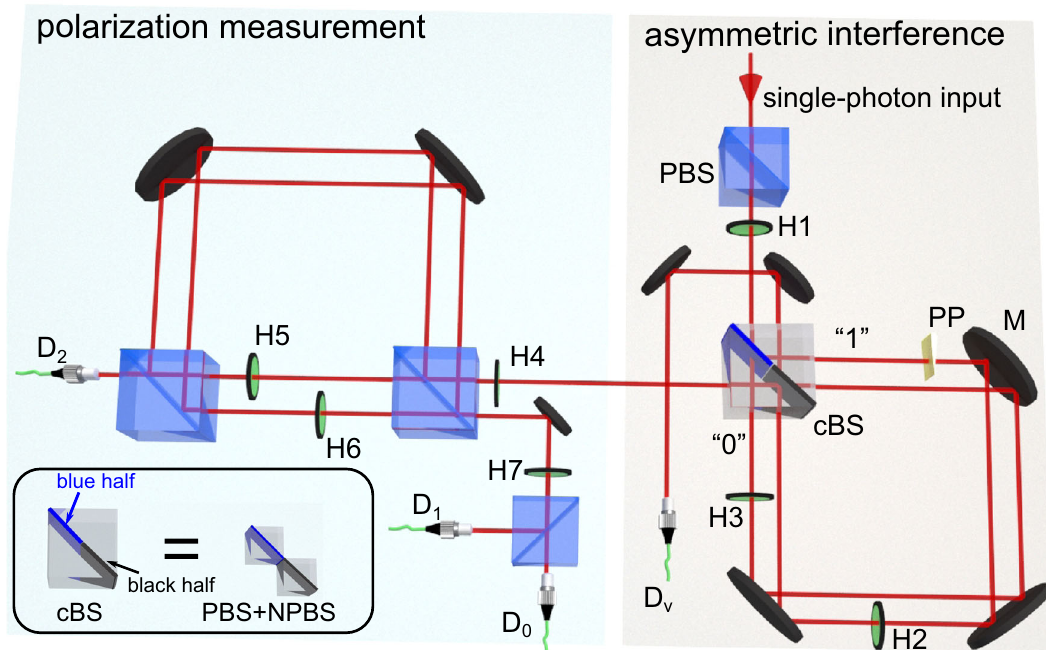
Fig. 3 Schematic of the experiment. (1): asymmetric interference. The photon transmits through the fi rst PBS and is then rotated by the fi rst half-wave plate H1. The blue half of the cBS works as a PBS to split different polarization components. The photon traverses the two paths in the Sagnac-like structure and recombines on the black half of the cBS. H2 and H3 determine the fi nal states of the WWD. PP introduces a phase between the two paths. (2): polarization measurement. The polarization of the photon is analysed in the Sagnac-like structure. See Methods for the details of the implementation. The inset shows that the cBS is equivalent to an assembly of a PBS and a NPBS. When the photon is incident on the blue region, it works as a PBS; while when the photon is incident on the black region, it works as a NPBS. PBS polarization beam splitter, NPBS non-polarizing beam splitter, PP phase plate, cBS cubic beam splitter, M mirror, H1~H7 half-wave plates, D v , D 0 , D 1 , and D 2 single-photon